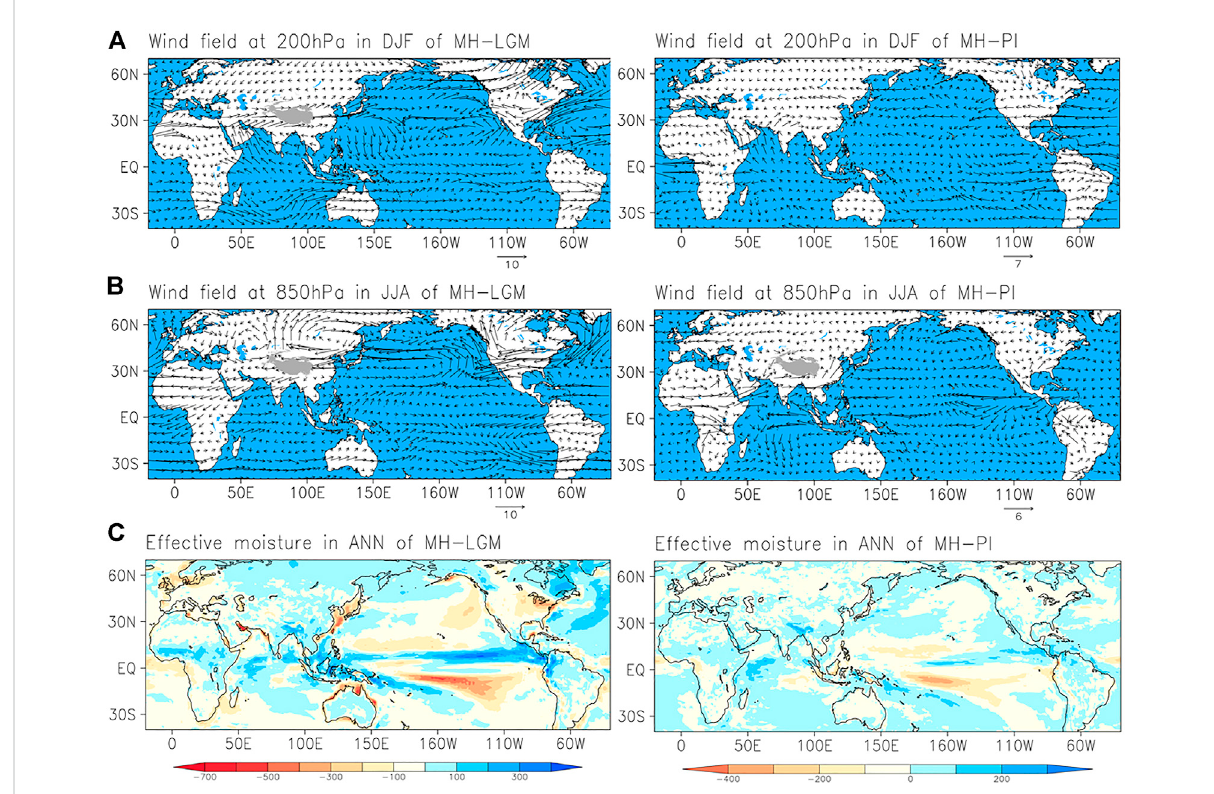
Schematic showing lacustrine archives for study (red wine circle), with modern monsoon area (blue circle). The modern monsoon area was calculated in terms of Wang ’ s method (Wang and Ding, 2008; Wang et al., 2012). The histogram displays different types and numbers of proxies selected in this study (for more precise sample information, see Supplementary Material). Abbreviations: EASM, East Asia summer monsoon; ISM, Indian summer monsoon; SASM, South African summer monsoon, South American summer monsoon; AISM, Australian-Indonesian summer monsoon; and NASM, North American summer